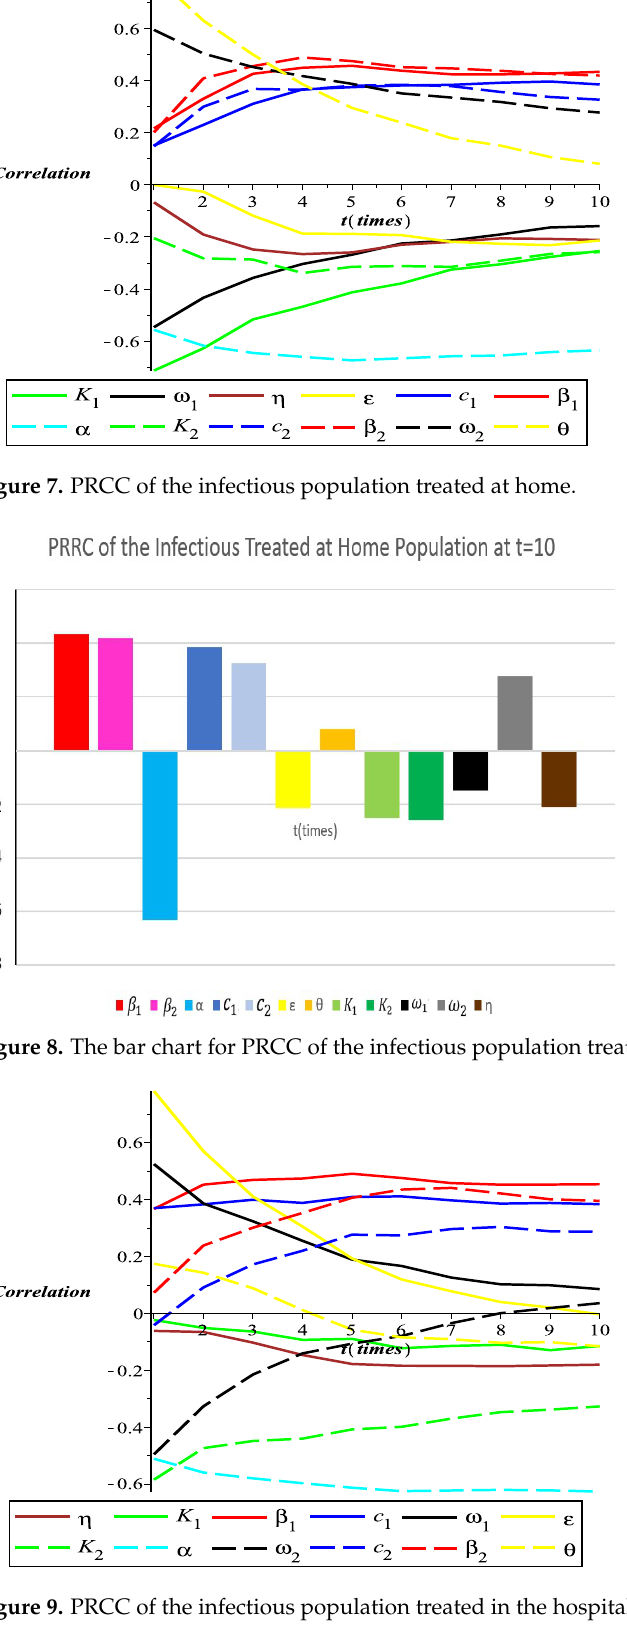
Figure 9. PRCC of the infectious population treated in the